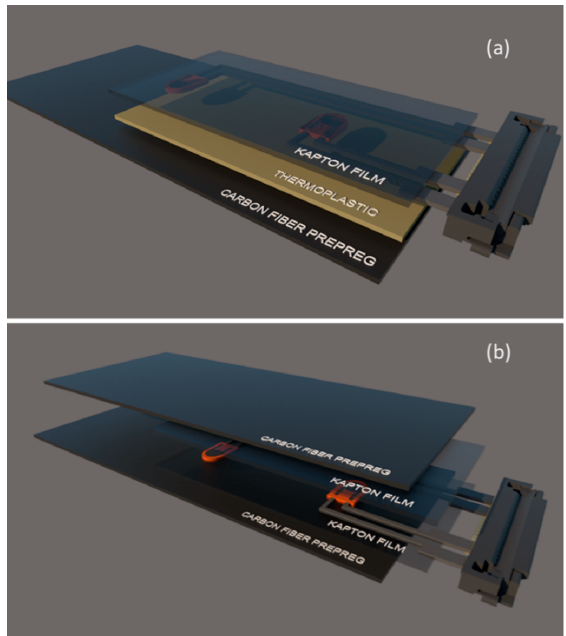
Figure 3. Schematic representation of ( a ) surface-mounted and ( b ) embedded diagnostic film.